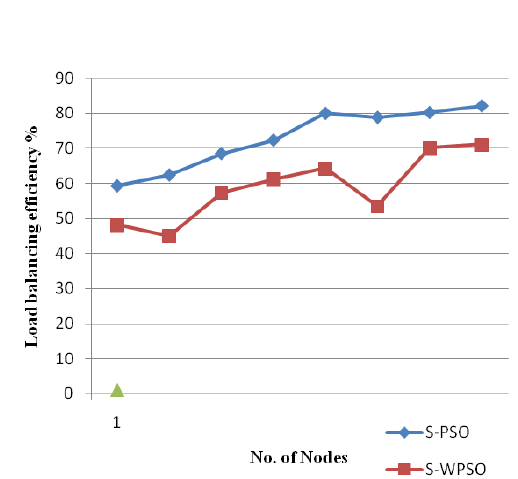
Figure 7. Load balancing efficiency of various nodes